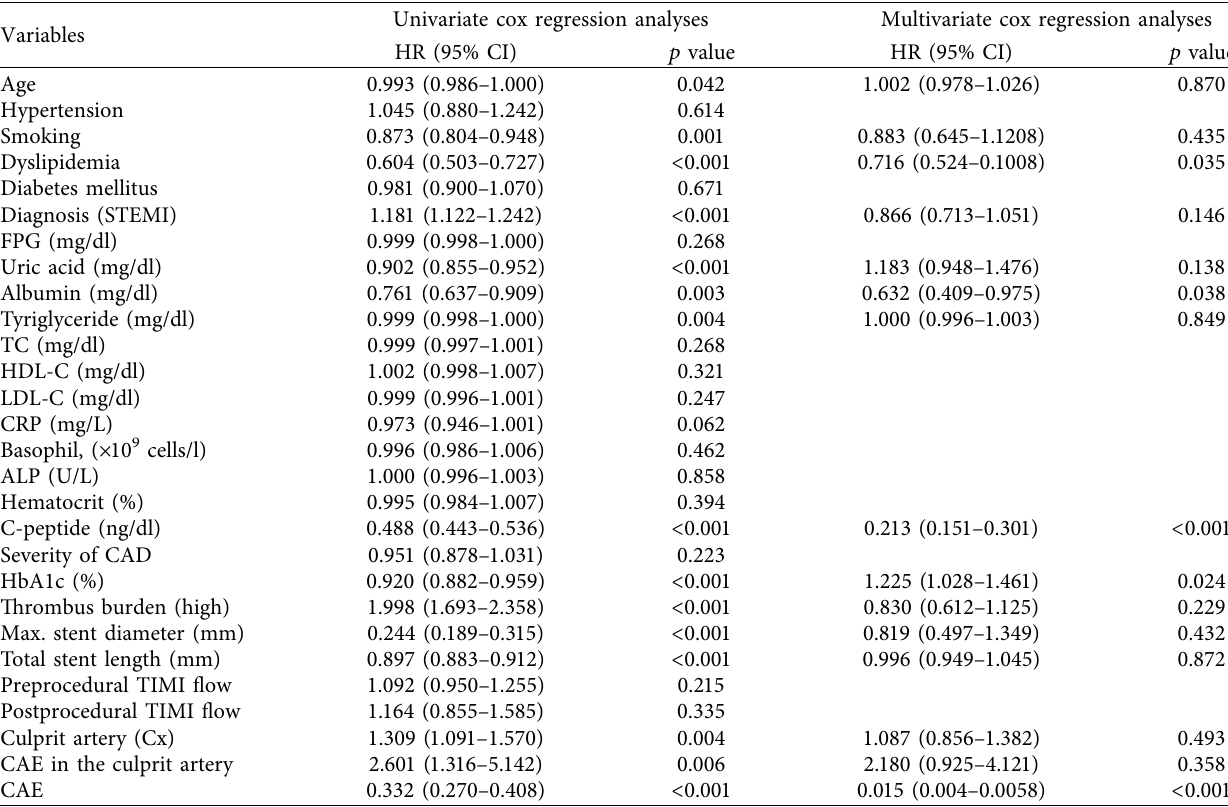
Table 6: Univariate and multivariate cox regression analysis to evaluate the association between C-peptide, CAE, and MACE. Univariate cox regression analyses Multivariate cox regression Variables